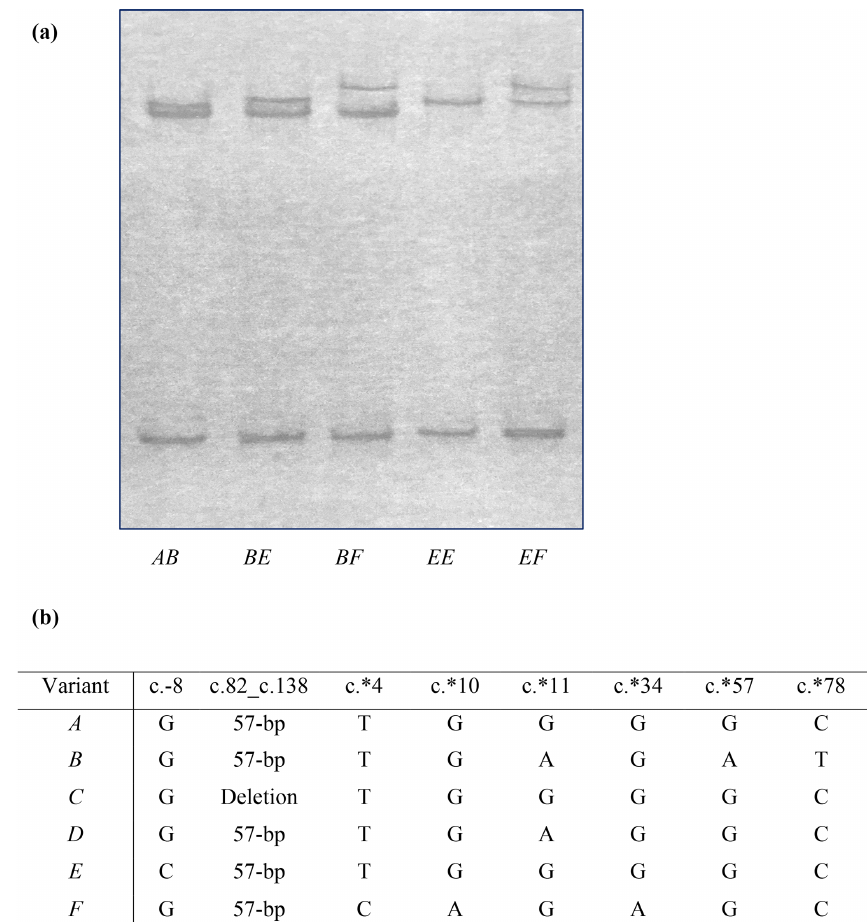
Figure 1. Polymorphism of ovine KRTAP6-1 . (a) Four variants ( A , B , E and F ) of ovine KRTAP6-1 were detected in New Zealand Romney ewes by PCR single-stranded conformational polymorphism analysis. (b) Sequence comparison of the four ovine KRTAP6-1 variants identified in this study, and those previously identified variants ( C and D ), revealed three new single-nucleotide polymorphisms (SNPs) at c. ∗ 4, c. ∗ 10 and c. ∗